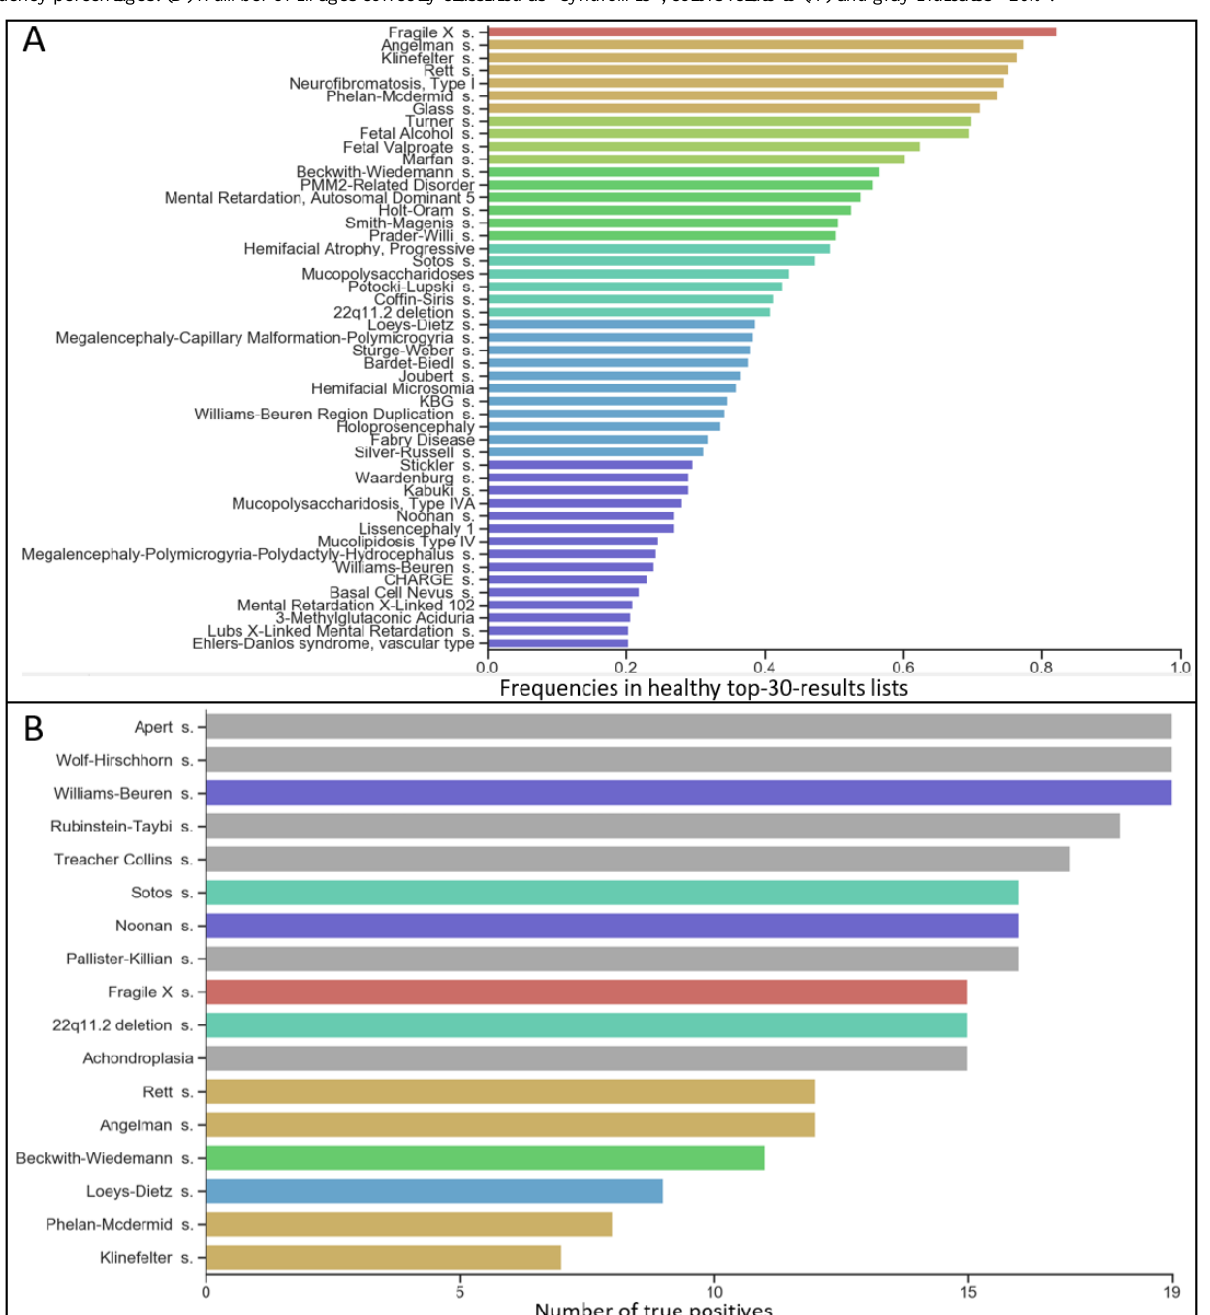
Figure 2. (A) Frequency of syndromes suggested by DeepGestalt in more than 20% of the matched control cohort’s top-30-results lists. Colors